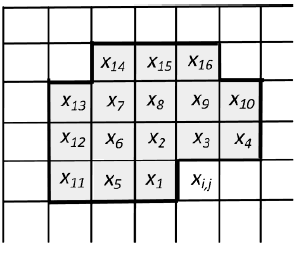
is the casual template (shaded , i j